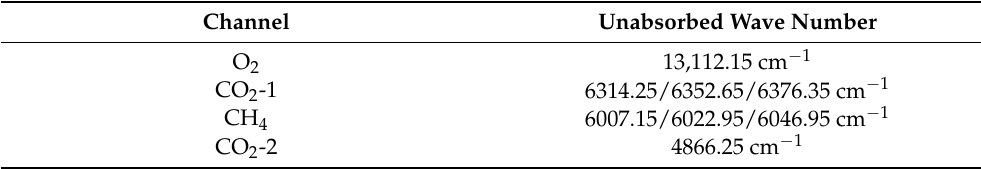
Table 7. Results of the four GMI channels’ unabsorbed wavenumbers.